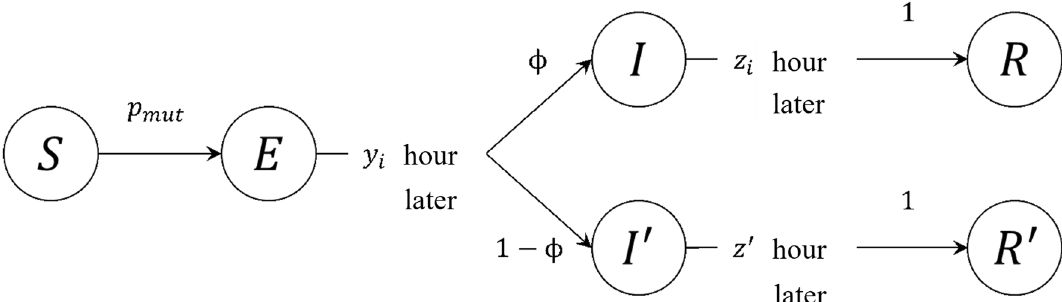
Figure 6. Agent infection status. S, E, I, and R state denote the infection states in the general SEIR model, respectively. I and R state denote asymptomatic infected agents, while I ′ and R ′ denote symptomatic infected agents. I and I ′ are determined to transition from E state by the probability φ